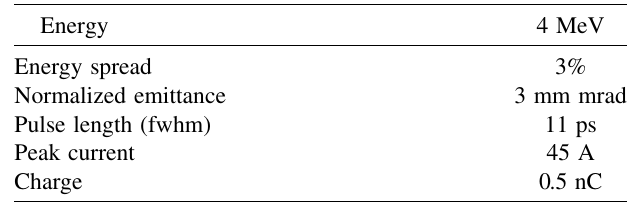
TABLE I. Beam parameters after the gun.